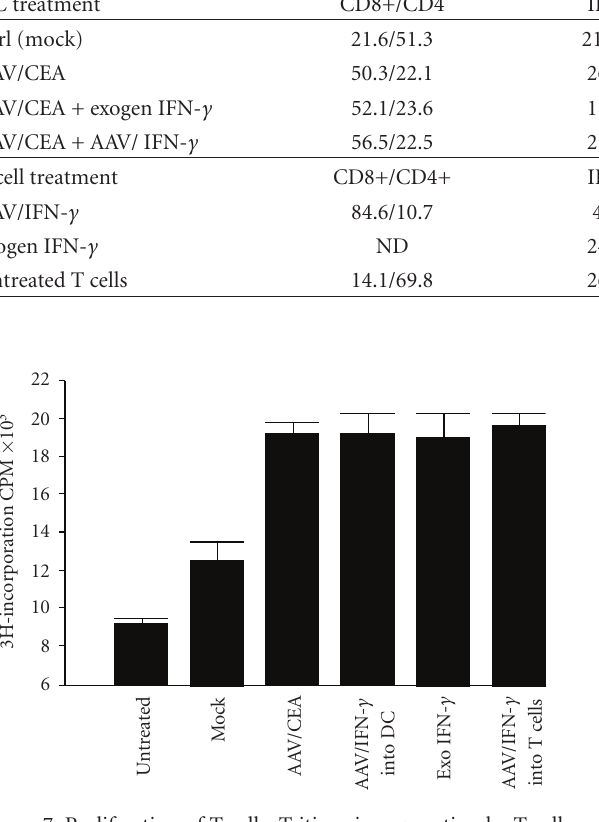
Figure 7: Proliferation of T cells. Tritium incorporation by T cells is shown under various